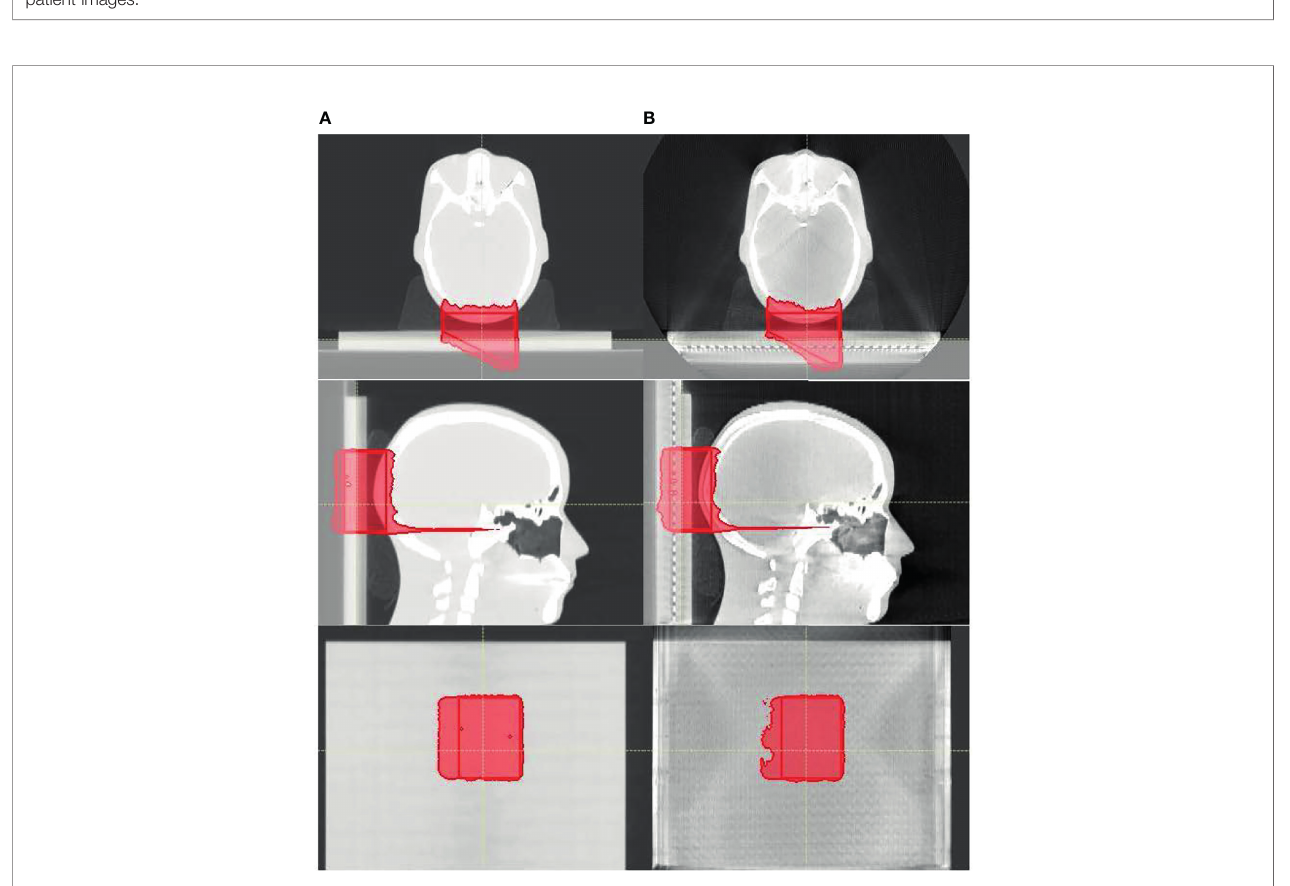
FIGURE 5 | The proton dose distribution calculated on (A) planning CT and (B) cone-beam CT (CBCT) for the head phantom. Only the prescription dose of 200 cGy is shown in the red color wash, and the red contour represents the